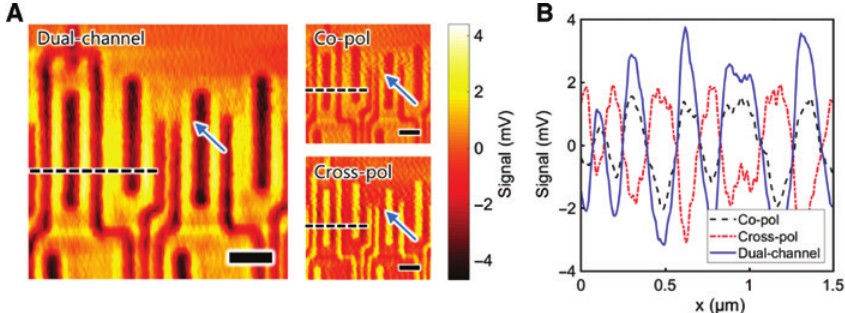
/air heterogeneous structure in dynamic random access memory (DRAM) patterns using the plasmonic Figure 5: Imaging results of the SiO 2 near-field scanning nanoscope